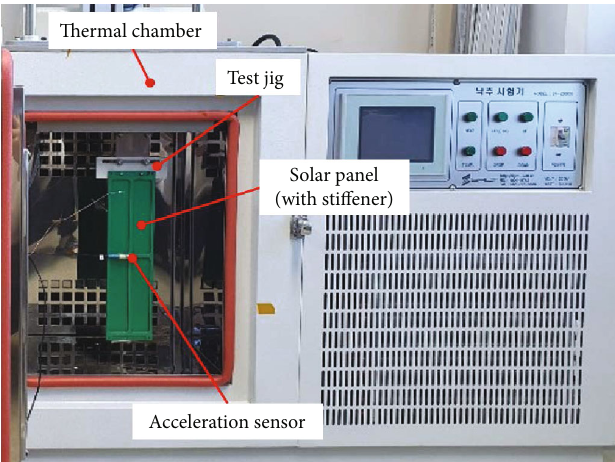
Figure 6: Free-vibration test setup con fi guration of the solar panel in a thermal chamber.